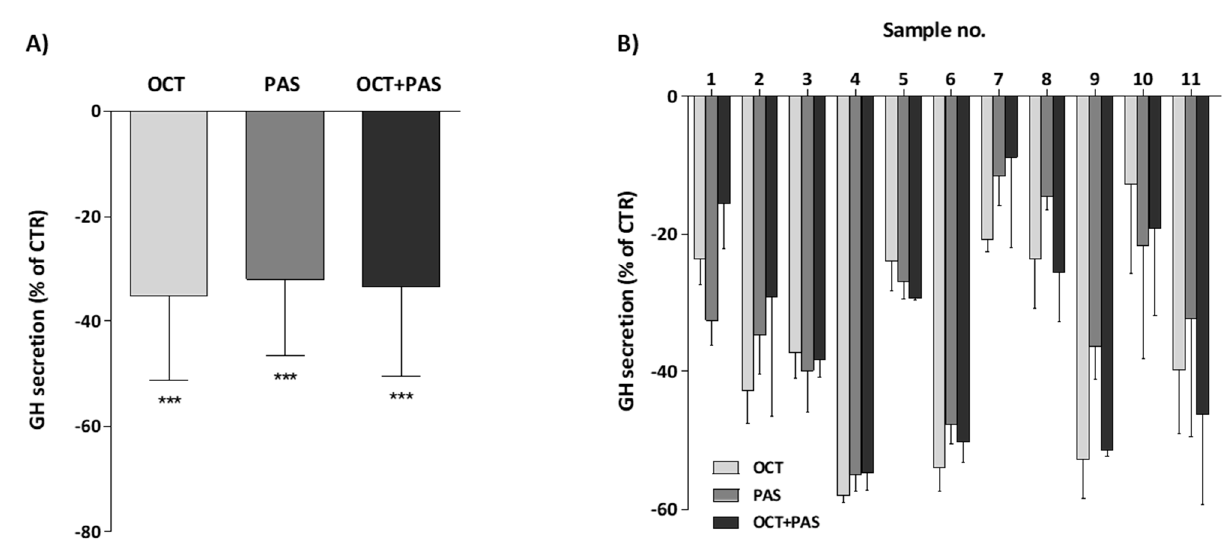
Figure 2. In vitro effect of OCT (10 − 8 M) and PAS (10 − 8 M), alone or in combination, on GH secretion in 11 primary cultures from somatotroph tumors. Panel ( A )) Overall efficacy of OCT, PAS and OCT+PAS after 72 h of treatment. Panel ( B )) Detailed antisecretory effect of OCT, PAS and OCT+PAS in the different cell cultures. Data are expressed as mean ± SD of each experiment, performed in triplicate, and reported as percent inhibition of control cells. (CTR, control; OCT, octreotide; PAS, pasireotide; ***, p < 0.001 vs. control).